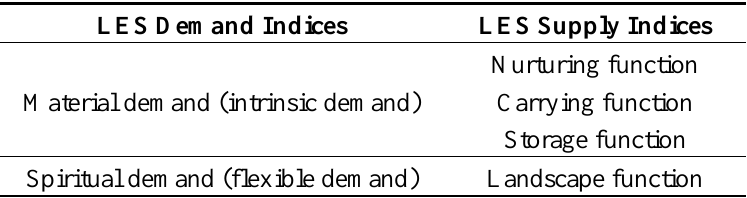
Table 1. Evaluation indices of land ecological security